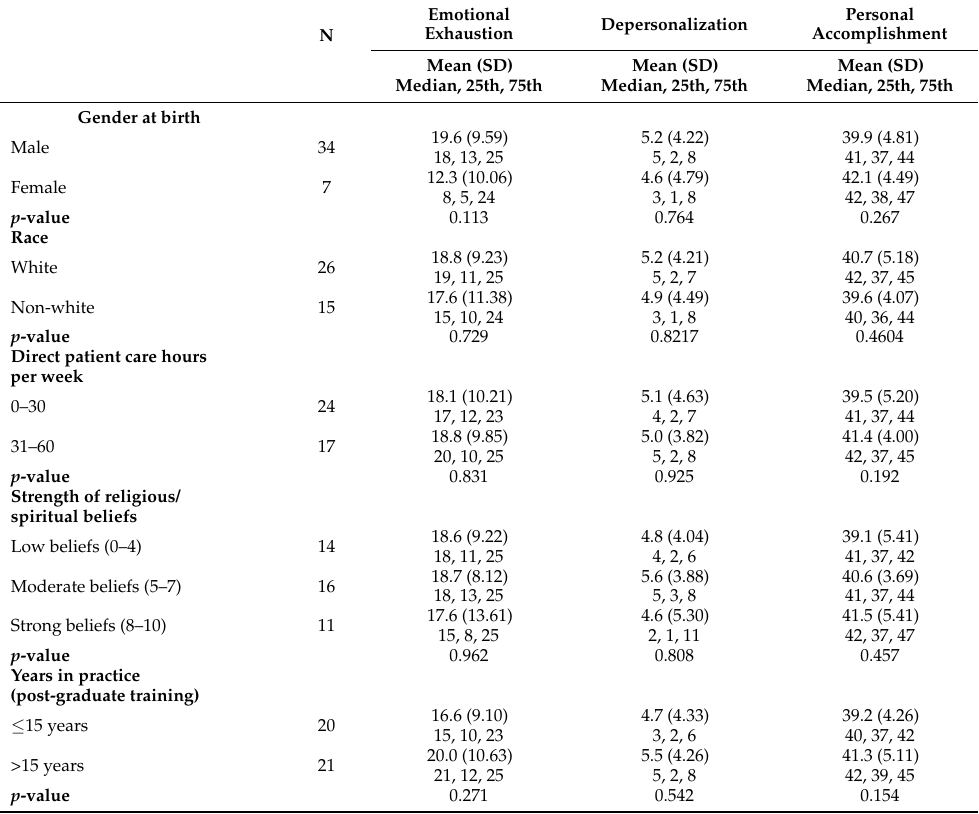
Table 2. Descriptive statistics of burnout scales by cardiologist characteristics